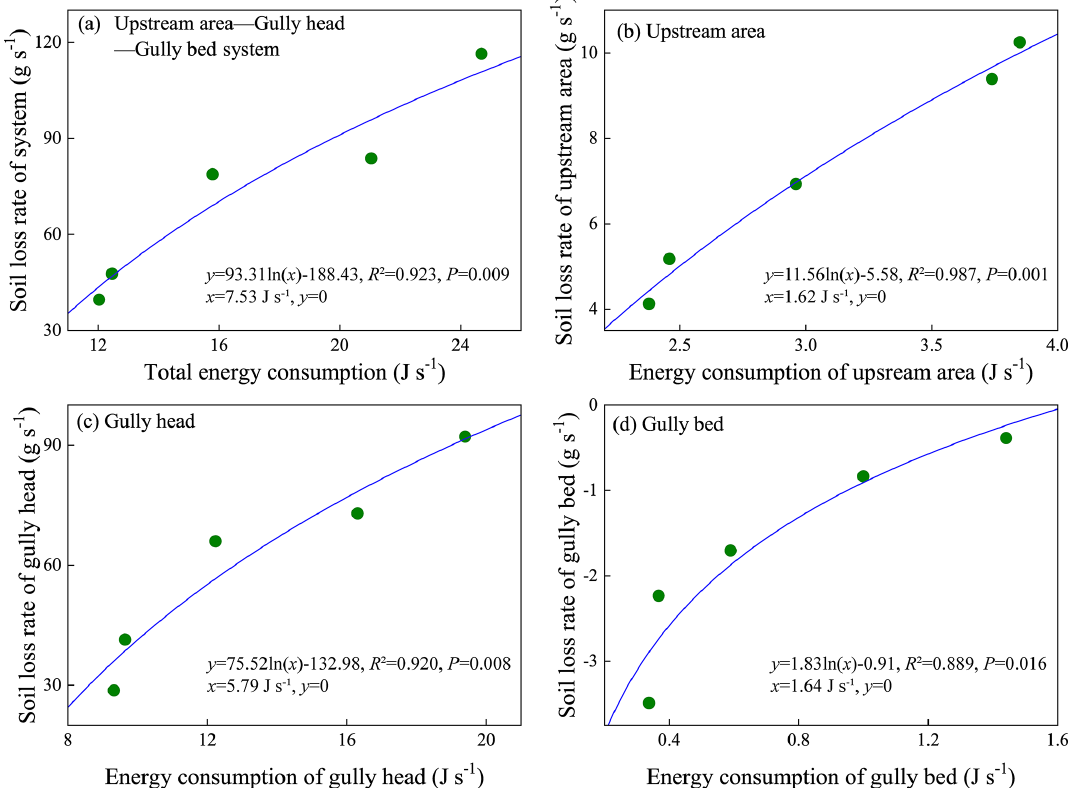
Figure 14. Relationships between the soil loss rate and energy consumption of the upstream area–gully head–gully bed system (a) , upstream area (b) , gully head (c) , and gully bed (d)